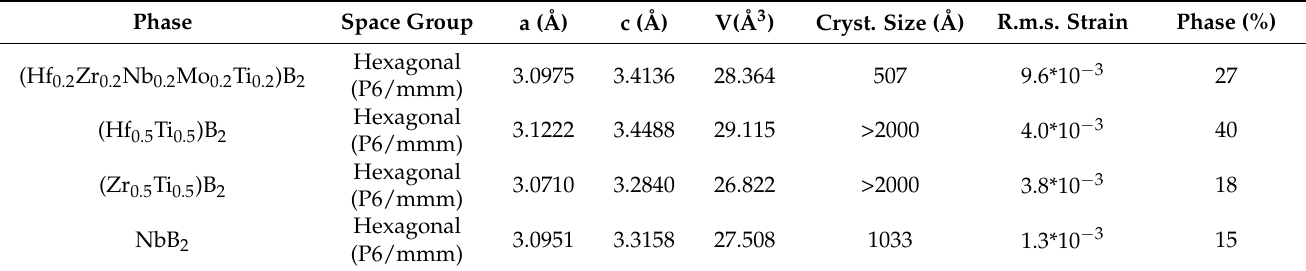
Figure 2. SEM micrographs and corresponding EDS elemental maps of ( a ) HEB_a, ( b ) HEB_b, and ( c ) HEB_c powders prepared by SHS.